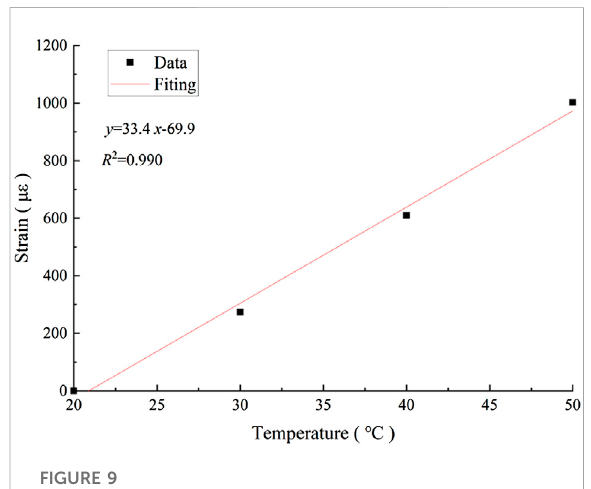
FIGURE 9 Fitting of the temperature of the logging system vs. the strain of the resistor.